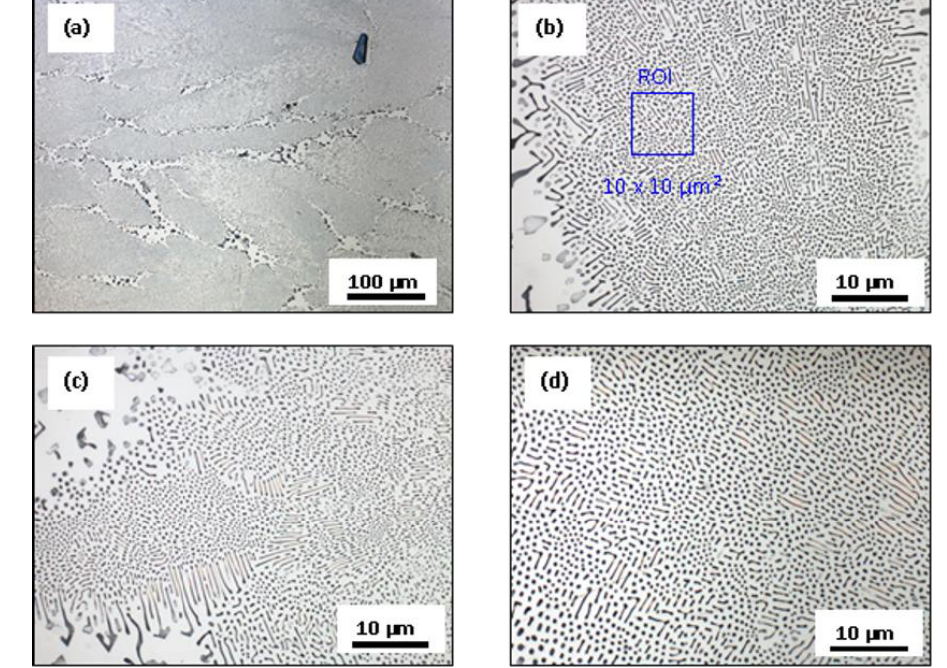
Figure 5. Microstructure of the Al-13.1 wt.% Mg 2 Si near-eutectic alloy at a 350 °C mold temperature,